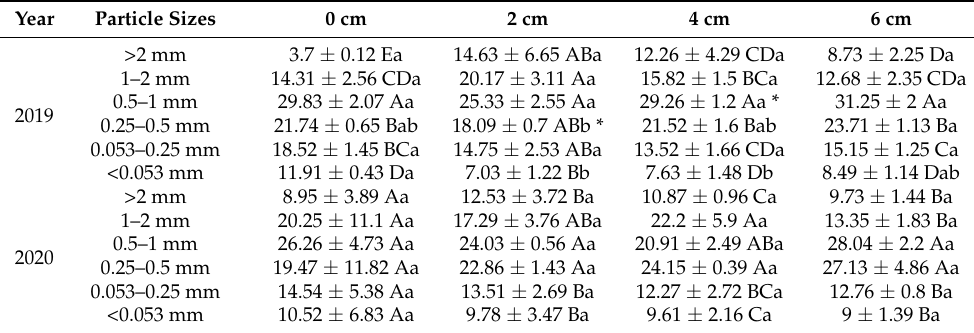
Figure 4. The effects of different treatments on soil composition proportions. Table 1. The composition proportion of aggregates of different particle sizes (%) from different straw mulching